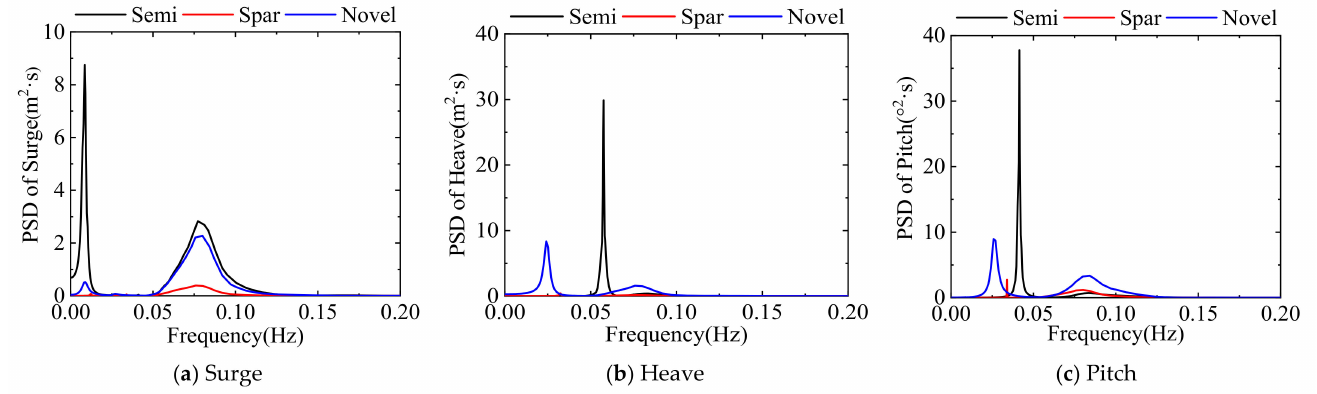
Figure 34. Power spectral density of the motion response of three